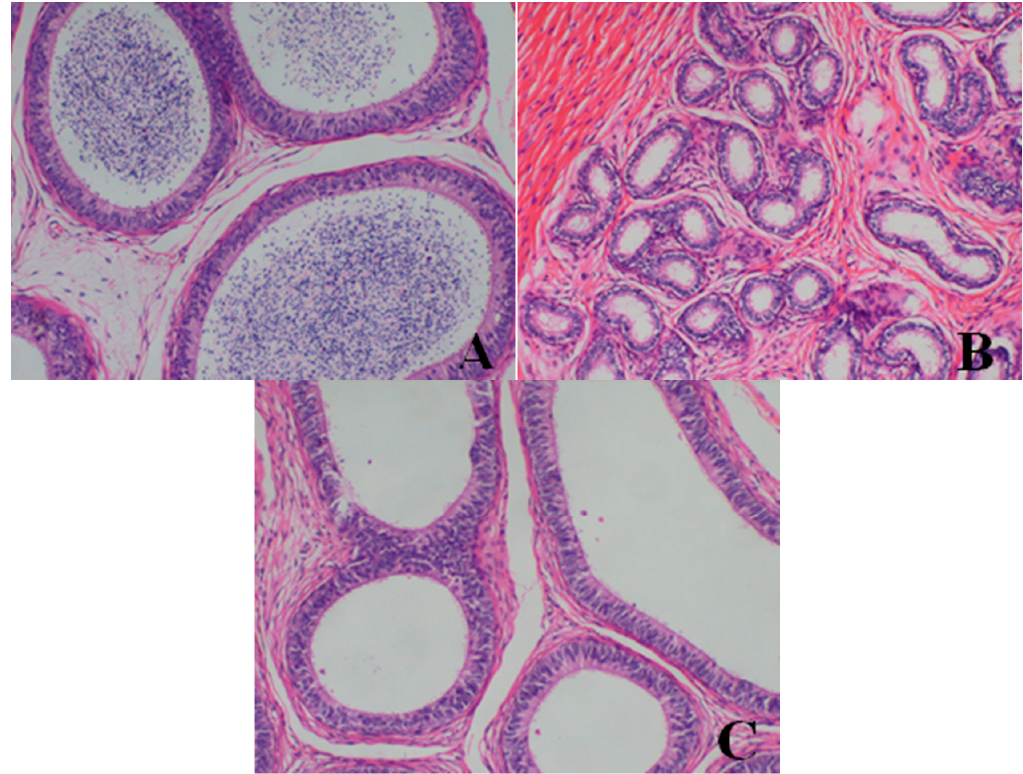
Figure 5. Hematoxylin and eosin-stained histologic sections of dogs’ testes ( A – C ) (original magnification × 100). ( A ) Histopathological photomicrograph of testis from ♂ 29 belong to the control group at d28: normal; ( B ) testis from ♂ 5 belonging to the 80-mg/kg dose group at d28; ( C ) testis from